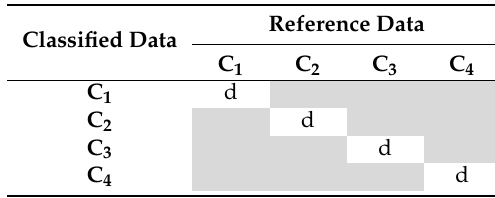
Table 2. Predesigned relative confusion matrix. Cell values in the diagonal (d) are 0.2375 for matrix CM 95 , 0.2 for matrix CM 80 , and 0.125 for matrix CM 50 . The sum of the off-diagonal values (in gray) is 0.05 for matrix CM 95 , 0.2 for matrix CM 80 , and 0.5 for matrix CM 50